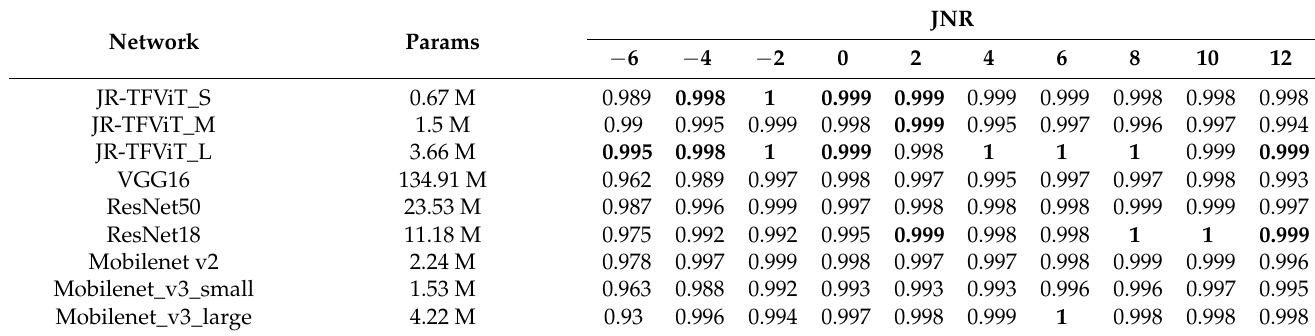
Table 6. The F1 score of the nine networks in different JNR conditions.